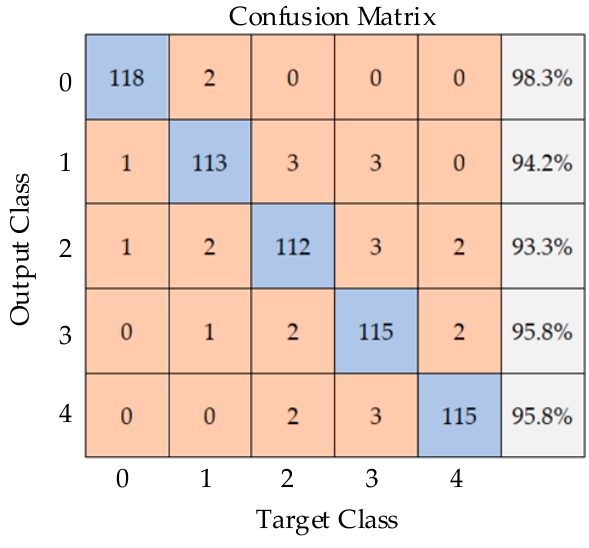
Figure 20. Confusion matrix.